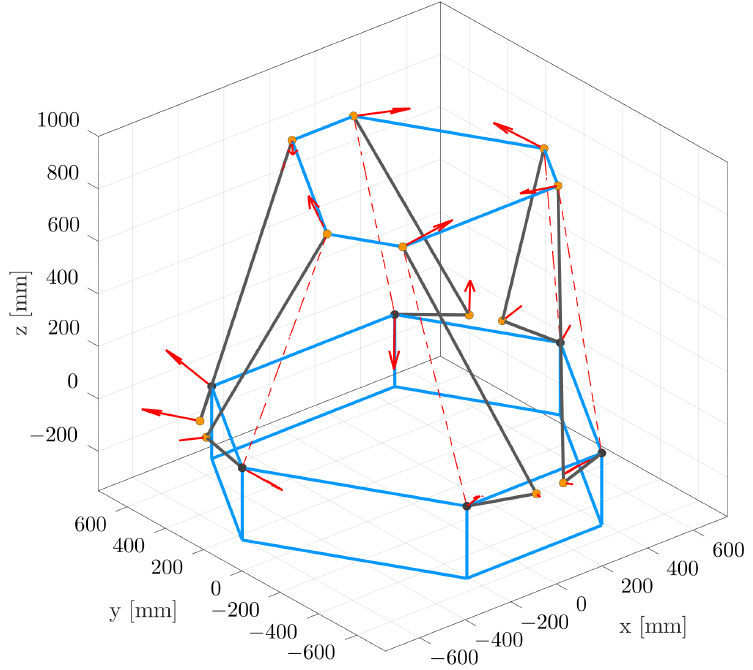
Figure 15. Kinematic model of optimized mechanism